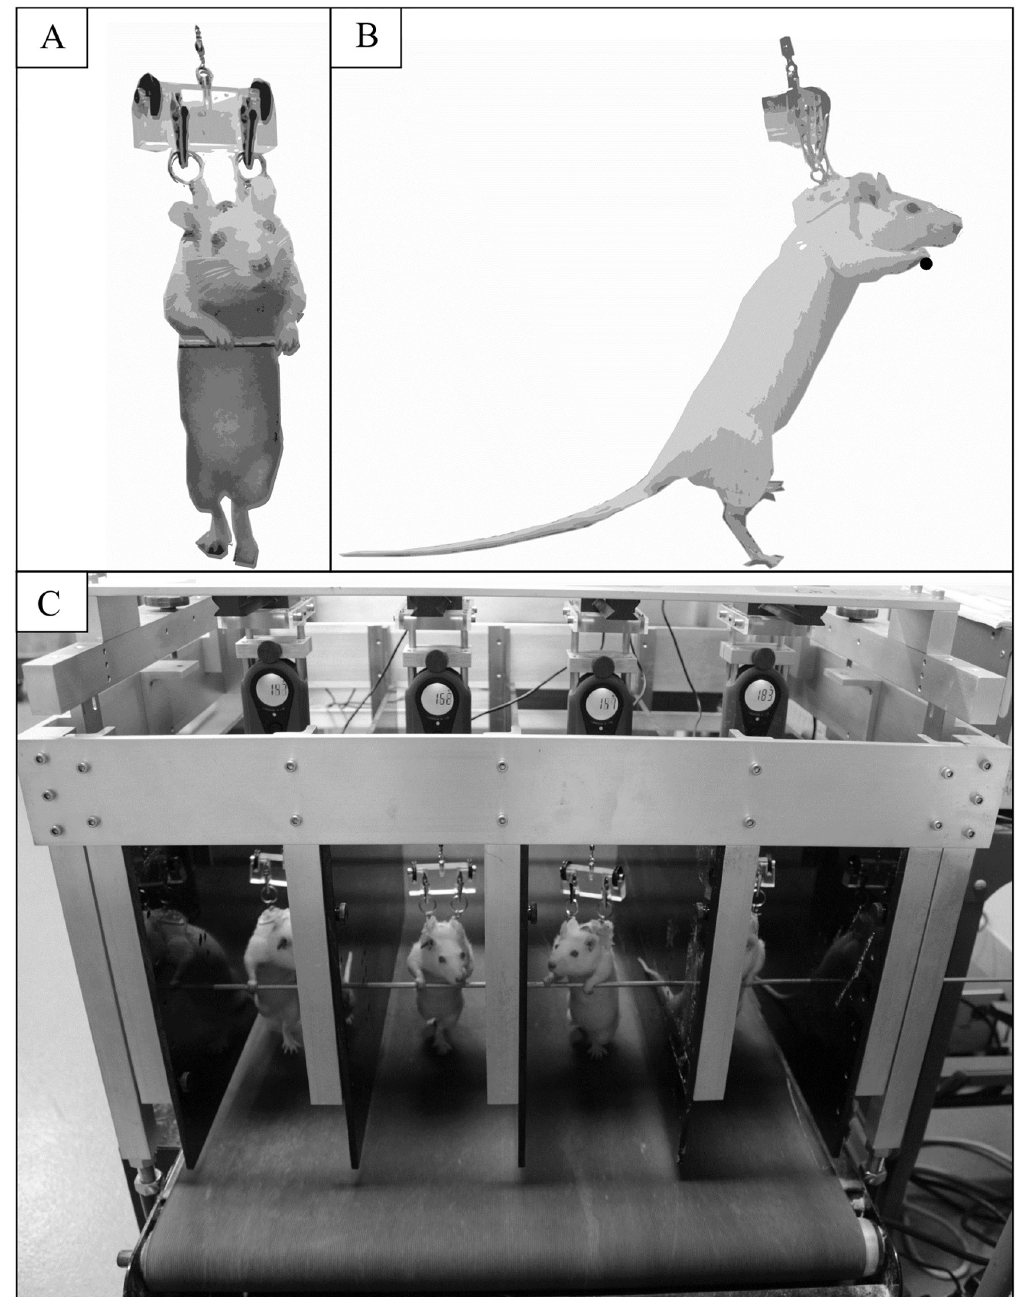
Fig 1. Harness system for bipedal walking and posture in rats. Rats walking bipedally in front view (A) and side view (B), using a harness system mounted on a large animal treadmill and a horizontal support bar, configured in a four lane configuration (C). A hanging scale was mounted above each rat that attaches to a jacket worn by each rat that measured the amount of upward force on the torso (as a percentage of body mass), which was recorded by a data logger over the course of each exercise bout during the 12-week experimental period. Reprinted from [33] under a CC BY license, with permission from Foster, original copyright 2017. Figure available at https://dx.doi.org/10.6084/m9.figshare.5459749.